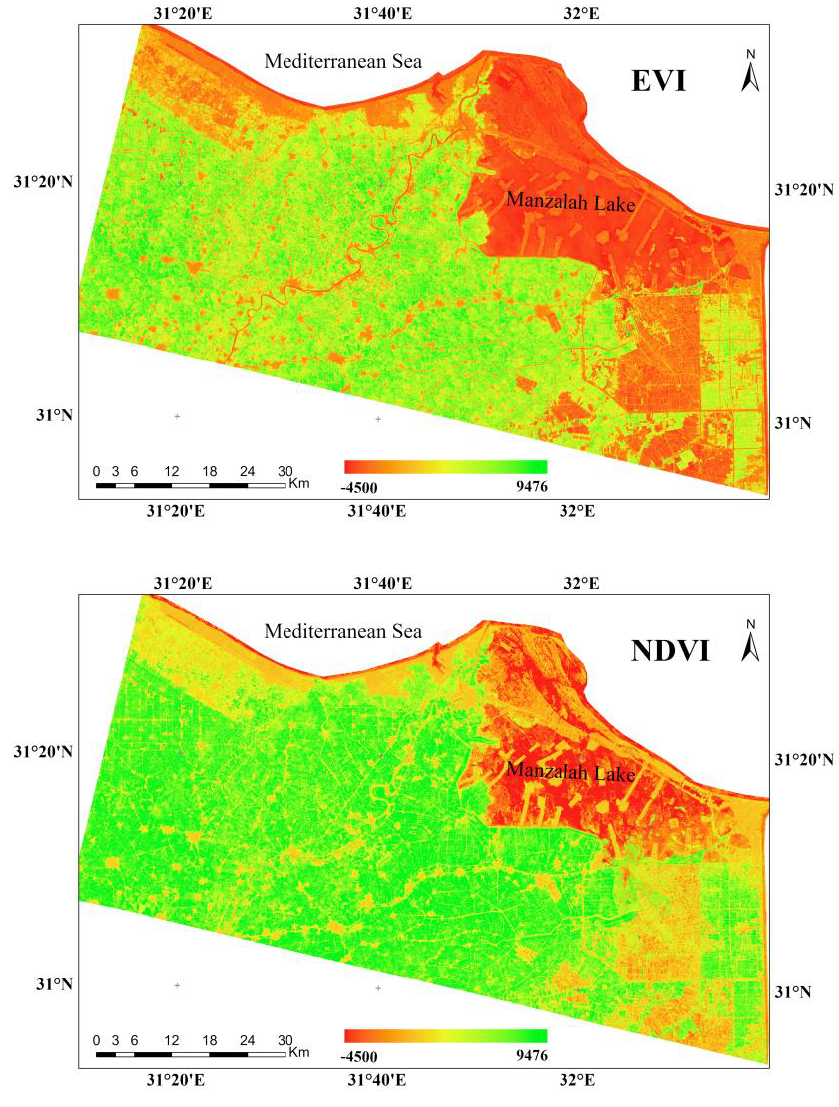
Figure 7. Remote Sensing Indices (RSI).